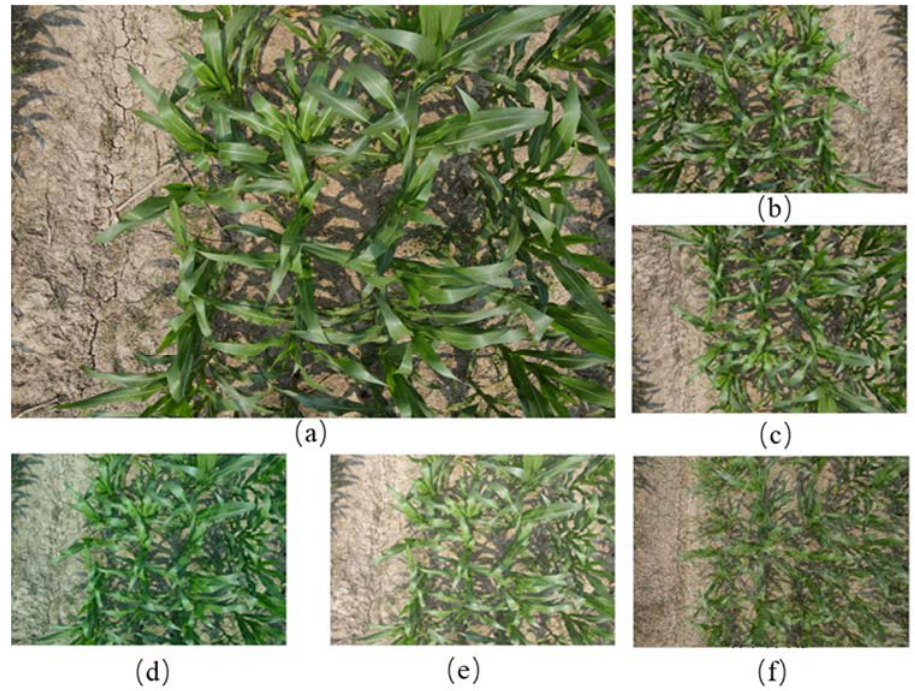
Figure 4. The example image and the corresponding results of different augmentation methods: ( a ) initial image, ( b ) vertical flip augmentation, ( c ) horizontal flip augmentation, ( d ) RGB shift augmentation, ( e ) contrast shift augmentation, and ( f ) mix ‐ up strategy.